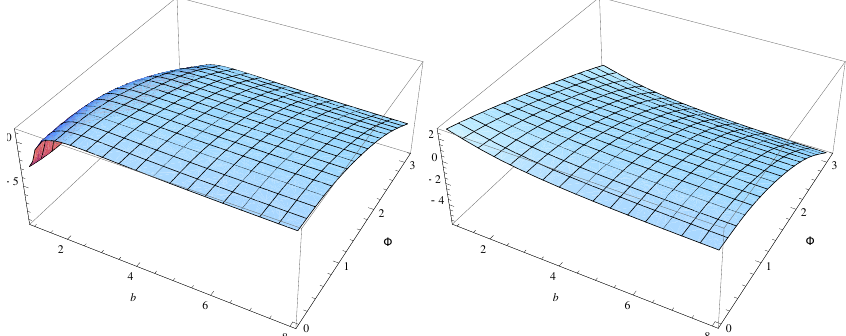
Figure 10. ( left ) The variation in total deflection 2 (cid:101) is shown with respect to b and φ . ( right ) Total deflection 2 (cid:101) is shown with respect to b and φ , for Schwarzschild case.